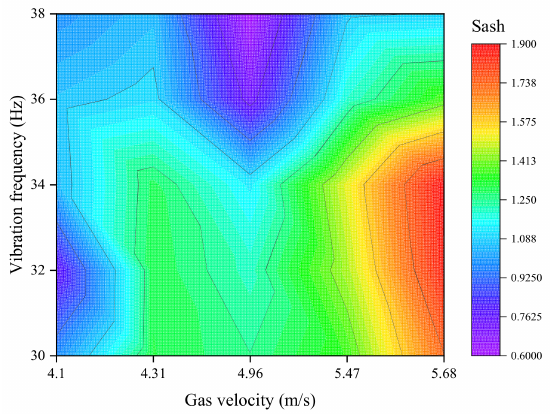
Figure 11. Variation of S ash of 6–0.5 mm